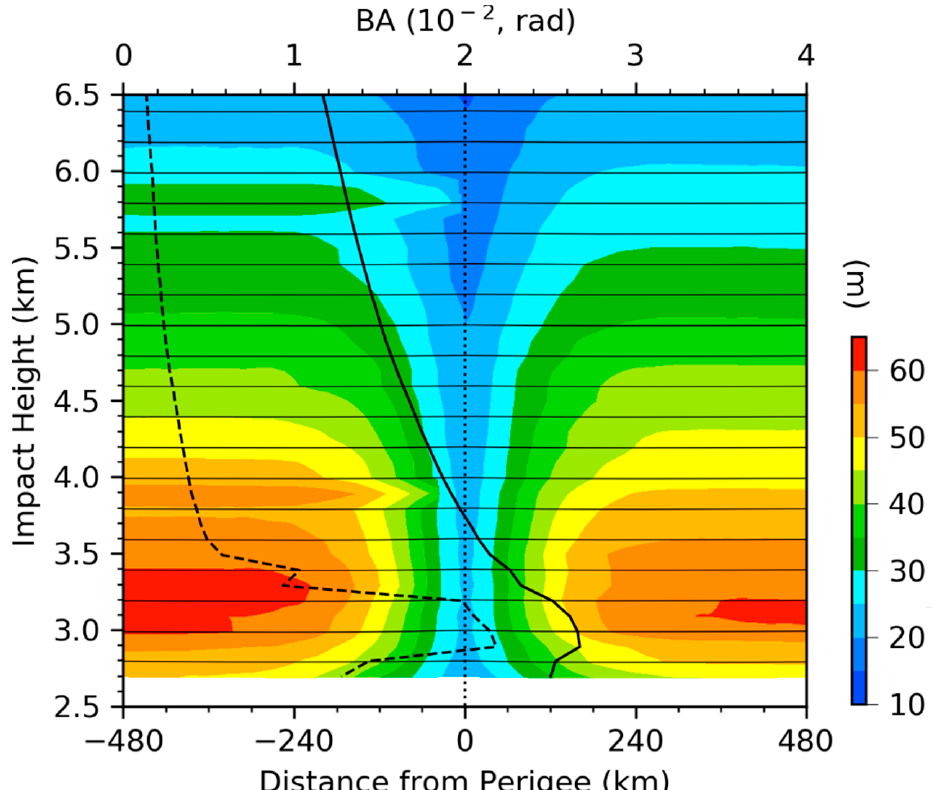
Figure 8. Variations in the means (thin black curves plotted at every other ray) and standard deviations (color shading) of the impact parameters of simulated ray paths with respect to impact height and horizontal distance from the perigee points, as well as the vertical profiles of the means (thick black curve) and standard deviations (thick dashed black curve) of the simulated bending angles. The means and standard deviations are calculated for rays at each 100 m interval of perigee impact height and 2 km interval of horizontal